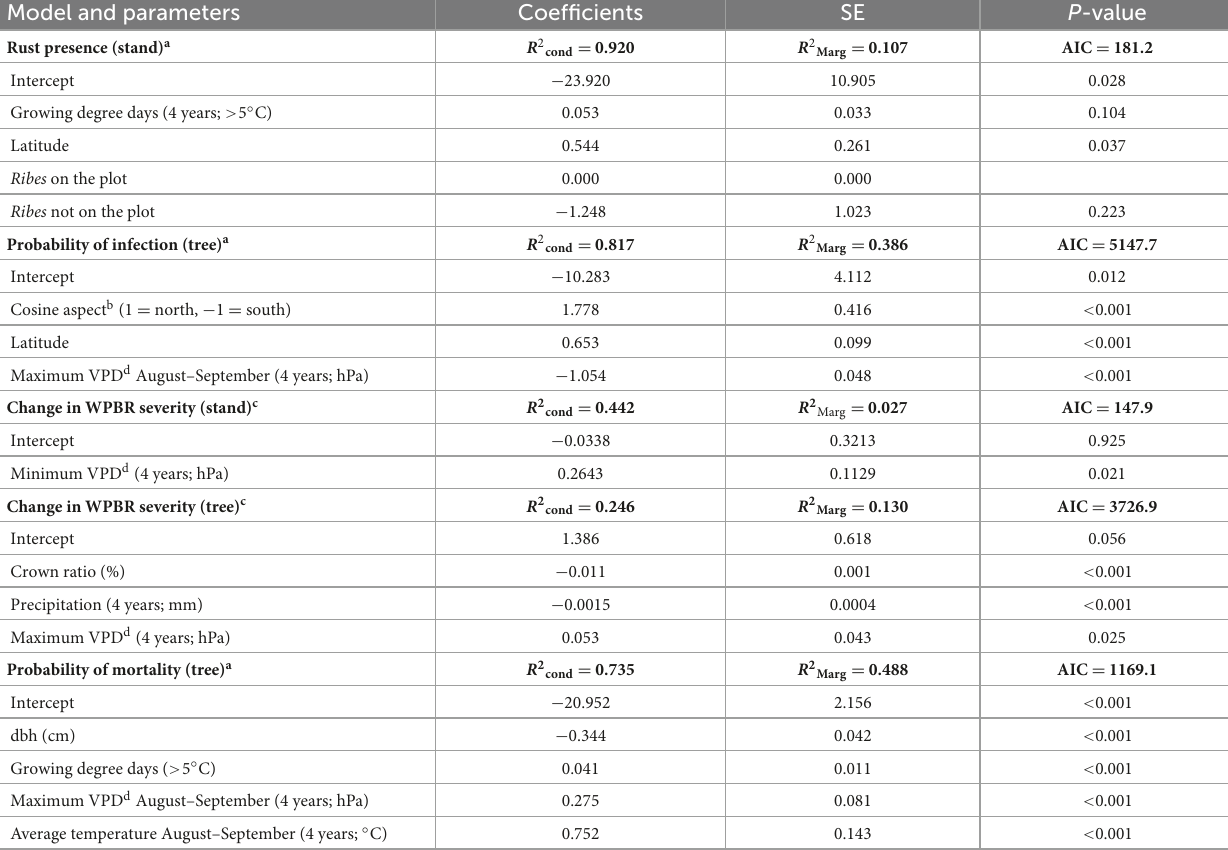
TABLE 5 Summary of best model subsets from final logistic and linear mixed-effects regressions predicting white pine blister rust presence, infection probability, change in disease severity, and probability of mortality at the tree and stand level. Model and